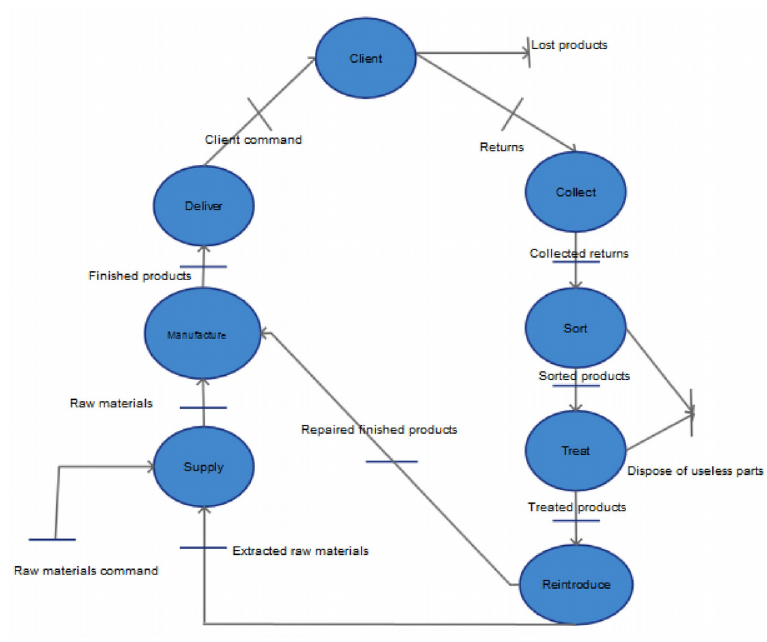
Figure 4. Global model for the combined Direct and Reverse